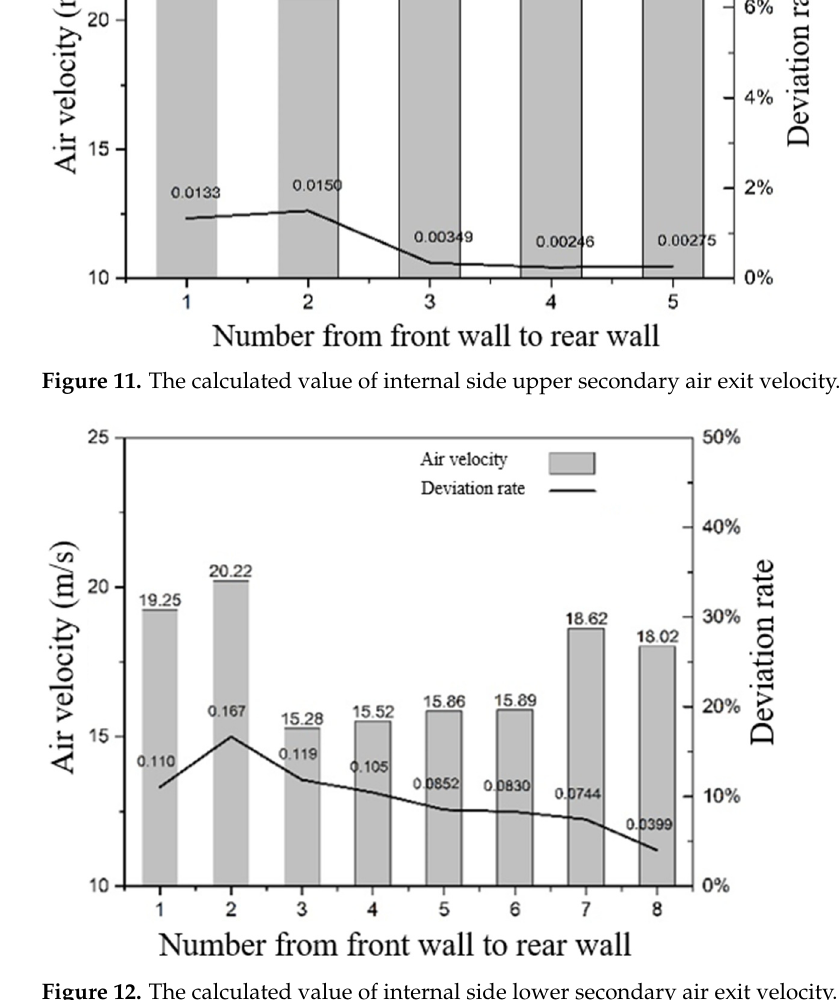
Figure 12. The calculated value of internal side lower secondary air exit velocity.